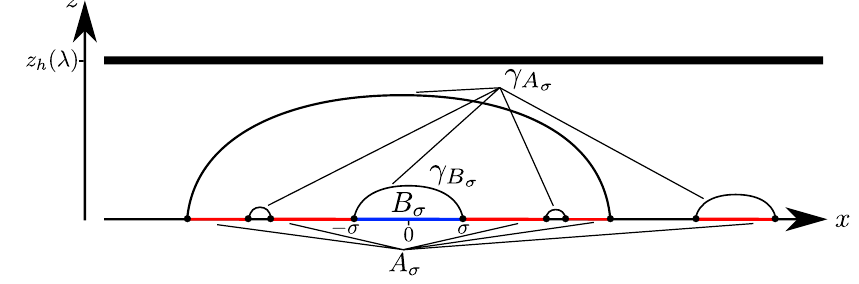
Figure 4 . A constant time slice of the black string geometry (2.1) revisited. The asymptotic boundary of this geometry | where the CFT is de(cid:12)ned | corresponds to the x -axis. The location of the black string is z = z h and depends on the energy density (cid:21) via (2.2). It is possible to choose a union of intervals A (cid:27) (red) and an interval B (cid:27) (blue) that lies between two intervals that belong to A (cid:27) in such a way that A (cid:27) and B (cid:27) saturate the ALI, i.e.